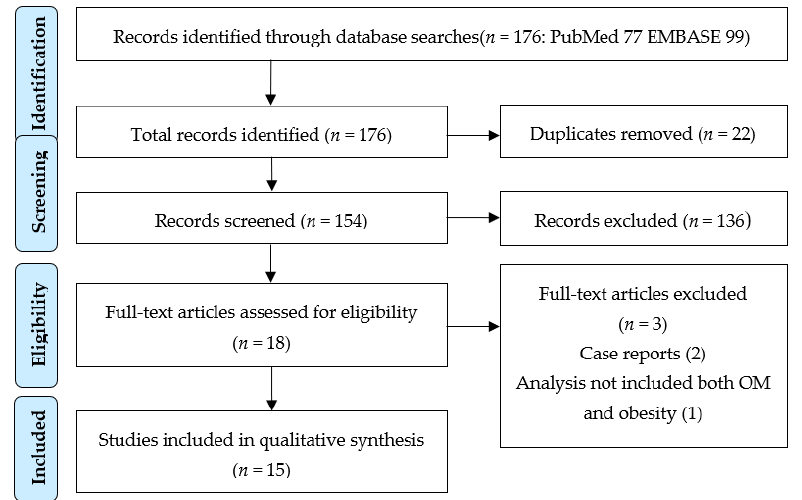
Figure 1. The PRISMA flow diagram for selection of studies for the review (NOTE: “Records” include a mixture of full journal articles of original research, published abstracts, protocols, invited commentaries, and reviews).